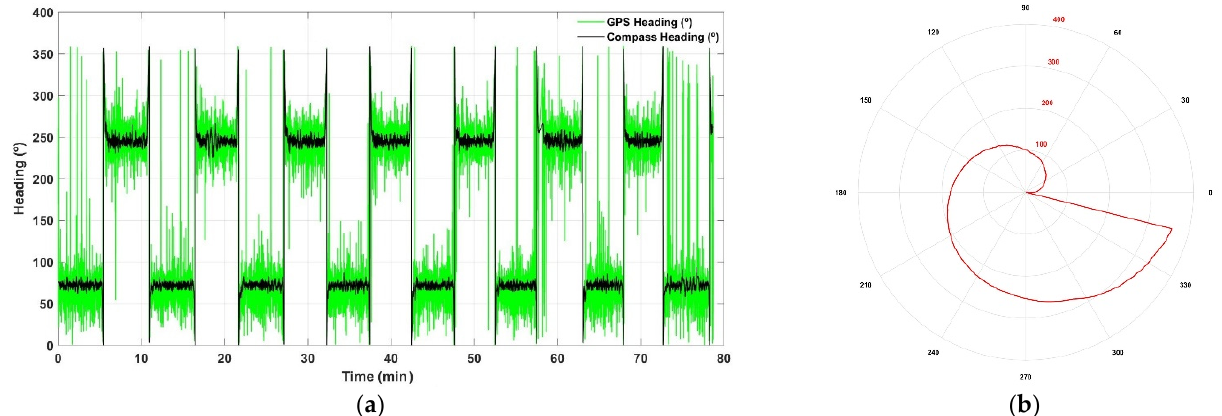
Figure 5. Heading estimation in agricultural vehicles: ( a ) comparison between a GPS receiver and an electronic compass; and ( b ) calibration map for electronic compasses.